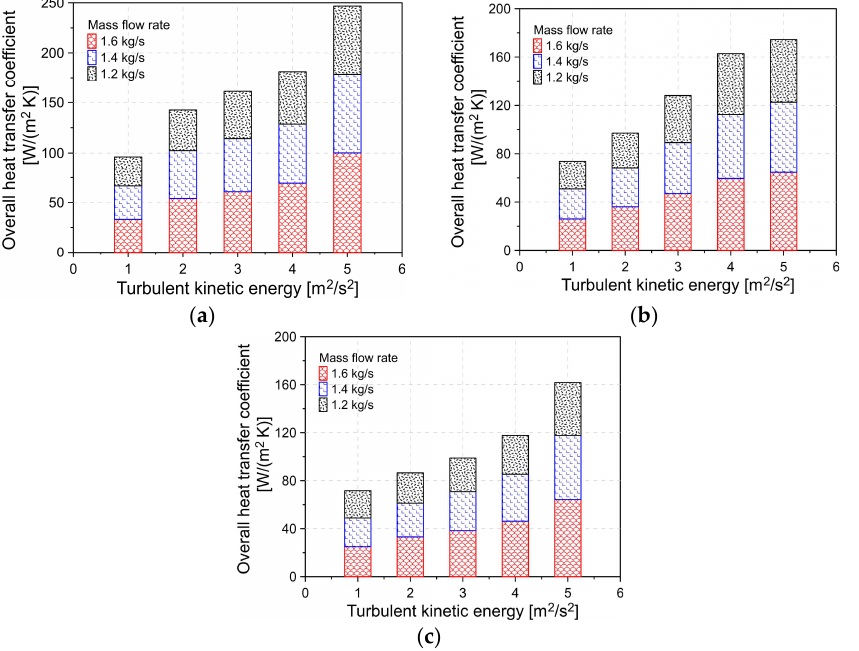
Figure 16. Flow Turbulent kinetic energy description of PCHE blocks: ( a ) conventional zig-zag channel; ( b ) modified zig-zag channel; ( c ) straight channel.